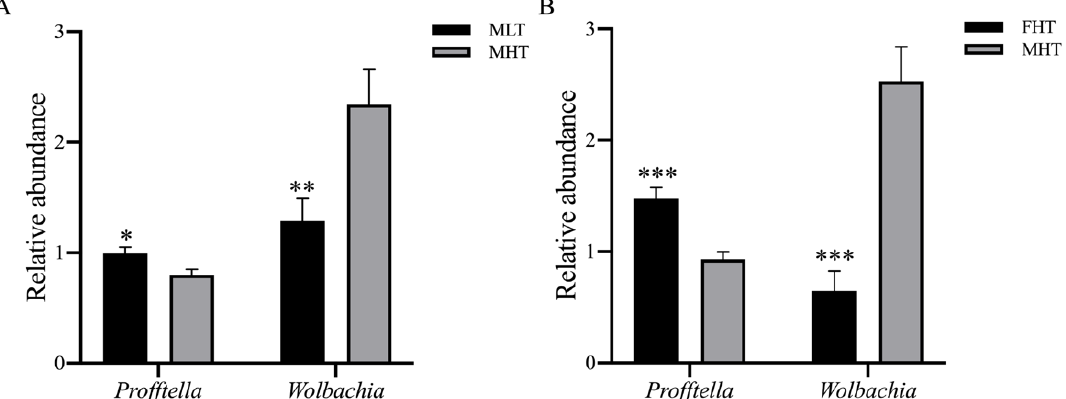
Figure 5. RT-qPCR validation of high-abundance bacteria ( Profftella and Wolbachia ) both in ( A ) MLT and MHT and ( B ) FHT and MHT, as well as a high relative abundance (>0.1%). The relative expression level of ASV 16S rRNA is an index of the bacterial abundance. Two reference genes, GADPH and actin , were used to normalize the 16S rRNA expression level in qBASE. The mean (±SE) expression level was based on 10 biological replicates. Significant differences between MLT and MHT and between FHT and MHT of D. citri were compared by Student’s t -test and are indicated by asterisks (* p < 0.05; ** p < 0.01; *** p < 0.001). FHT and MHT: female and male under a high-temperature treatment (42 °C); MLT: male under a low-temperature treatment (15 °C). Every group had four biological replicates of D. citri .